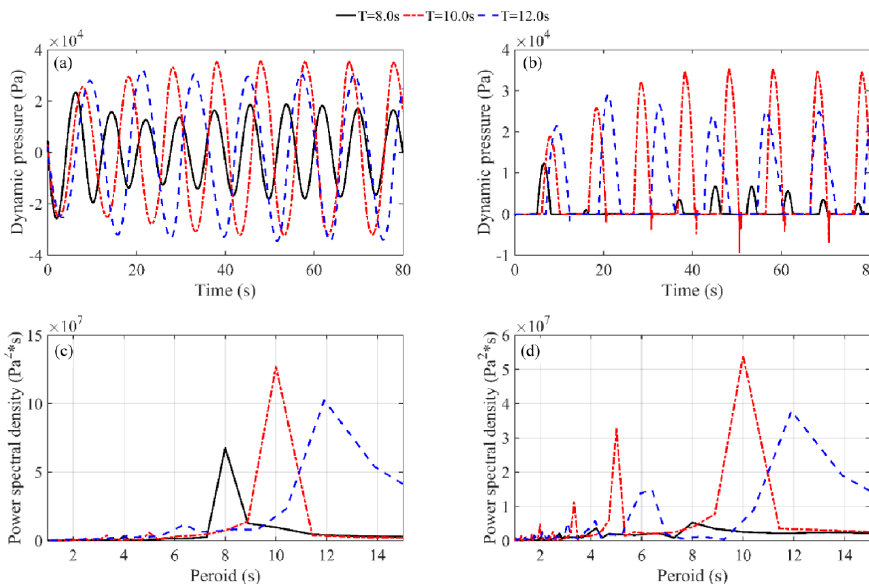
Figure 13. Dynamic pressures for the case of 50% filling of tank height under forcing period 8.0 s (black line), 10.0 s (dash-dot line), and 12.0 s (dash line) at ( a ): P2, ( b ): P4. The corresponding power spectra ( c ) and ( d ).